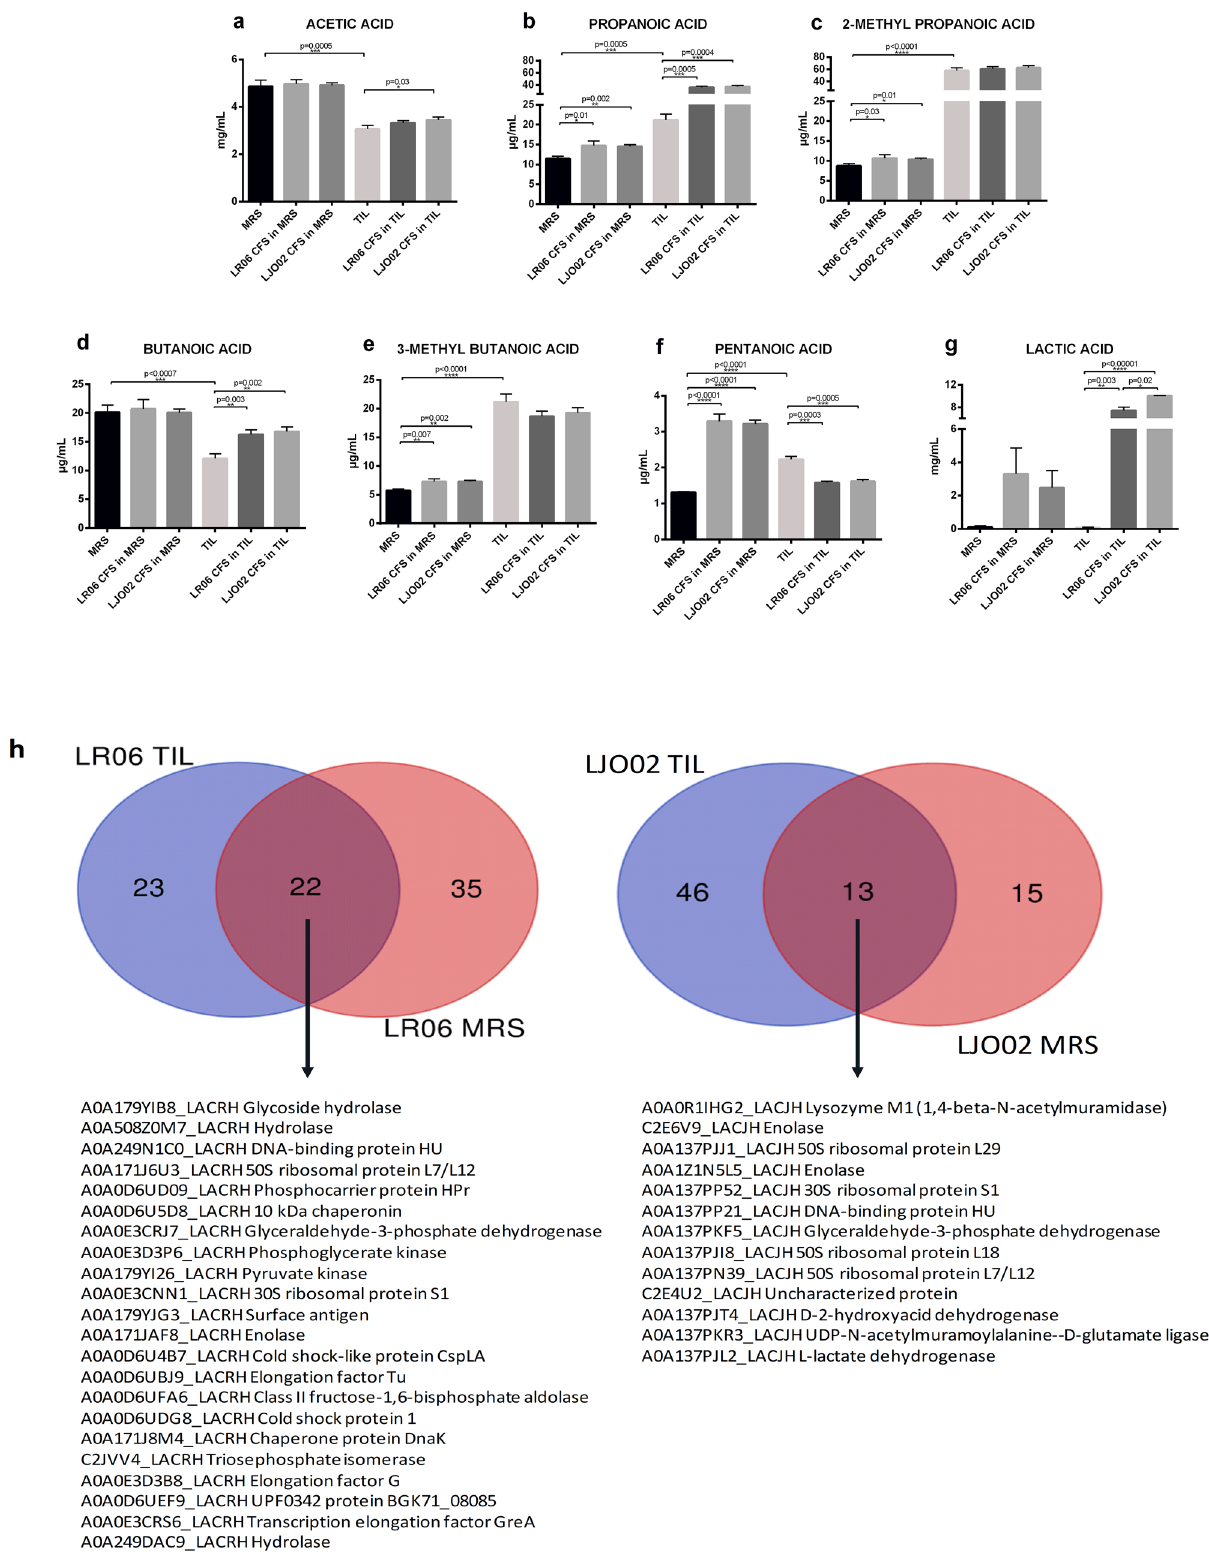
Figure 5. Quantification of SCFAs and characterization of protein content in CFSs from LR06 and LJO02 cultured in MRS and TIL for 8 h . ( a – g ) SCFAs amount in CFSs from LR06 and LJO02 produced in MRS and TIL. An unpaired t-test was applied. ( h ) Proteins identified in both MRS and TIL broths, and CFSs from LR06 and LJO02 cultured in both